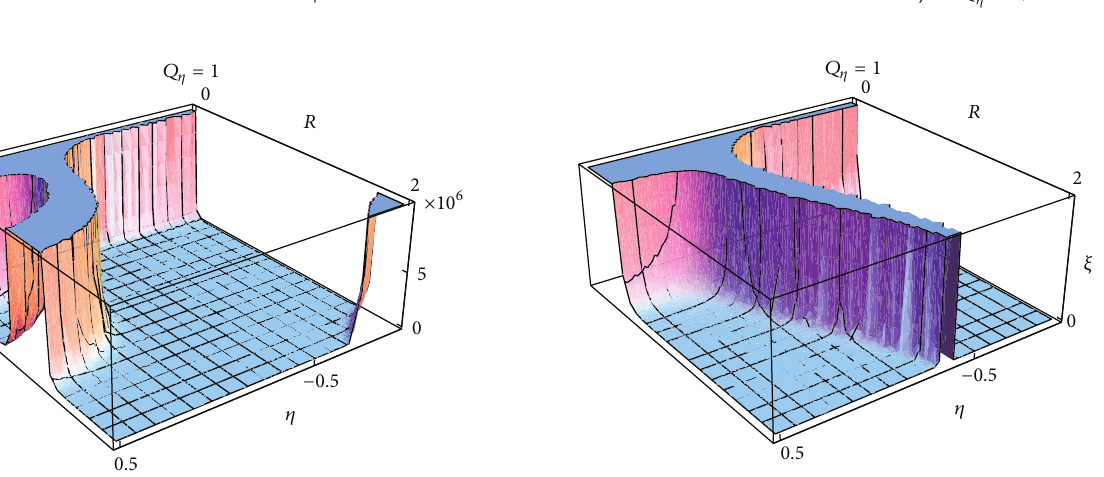
singularities, present on the brane, is banished in the